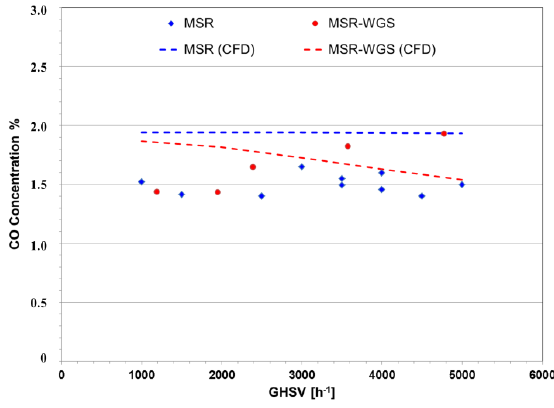
Figure 7. Concentration of CO in conventional PBRs containing a single MSR catalyst and a dual MSR-WGS catalyst at a pressure of 2 bar, a temperature of 475 °C and a steam-to-carbon ratio of five.